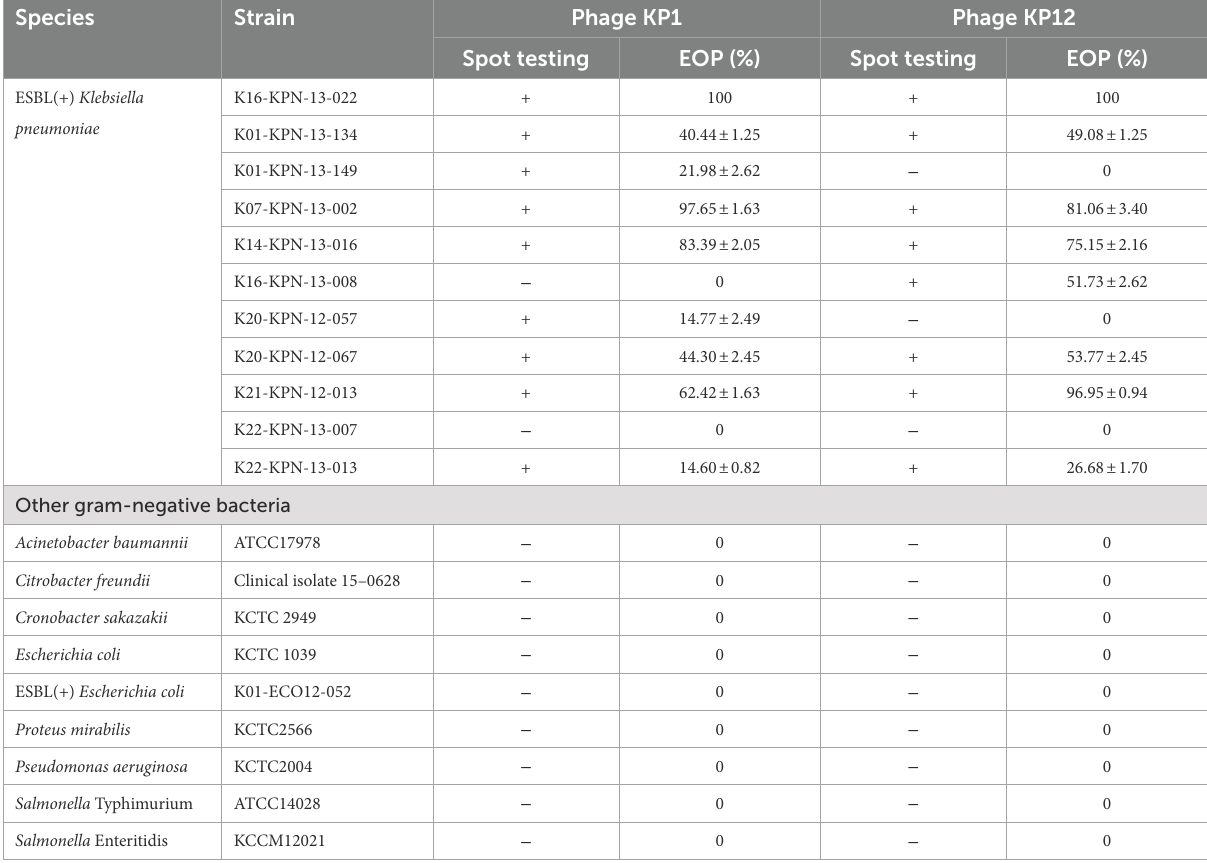
TABLE 1 Host specificity analysis of bacteriophage KP1 and KP12.